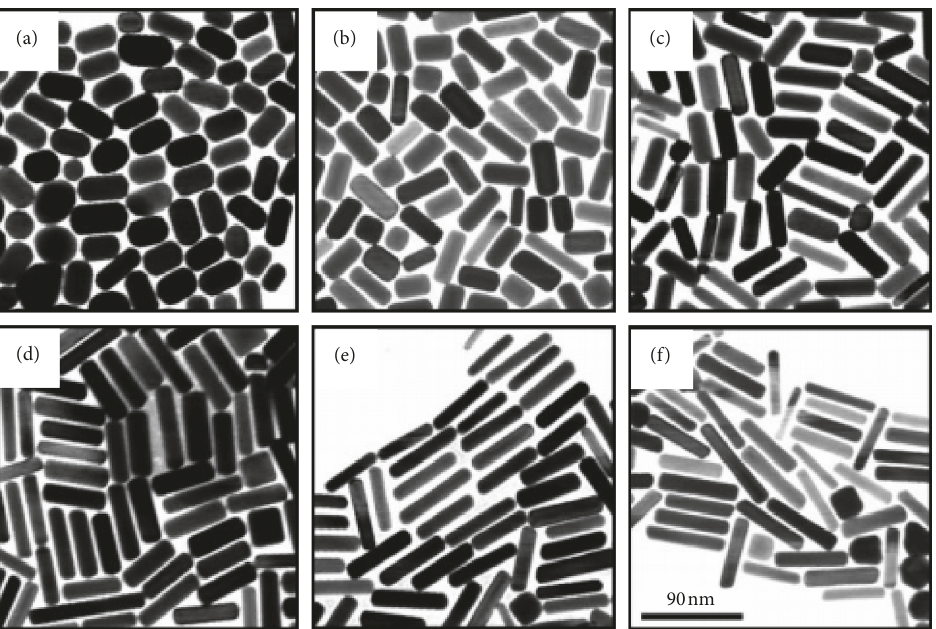
Figure 3: Illustration of gold nanorods of different aspect ratios in AgNO (d) 0.1, (e) 0.125, and (f) 0.15mmol − 1